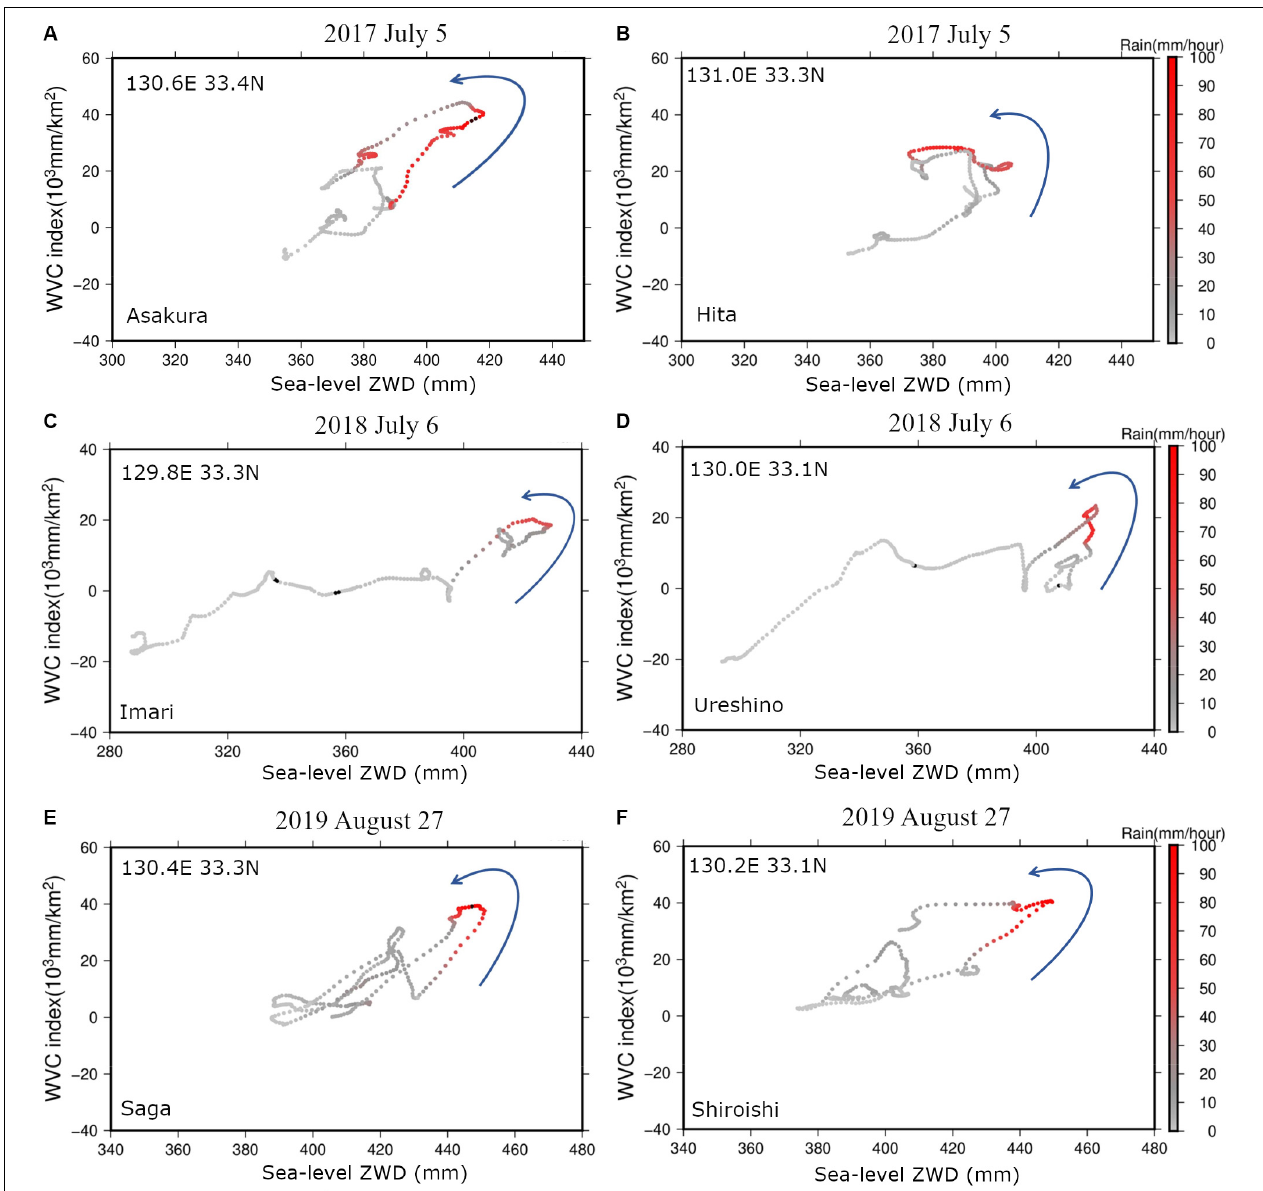
FIGURE 11 | High time resolution (5-min resolution) behaviors of rain rate in the sea-level ZWD-WVC space during the heavy rain days, July 5, 2017 ( A: Asakura, B: Hita), July 6, 2018 ( C: Imari, D: Ureshino), and August 27, 2019 ( E: Saga, F: Shiroishi). The color indicates hourly precipitation of AMEDAS stations interpolated to match the time resolution of sea-level ZWD and